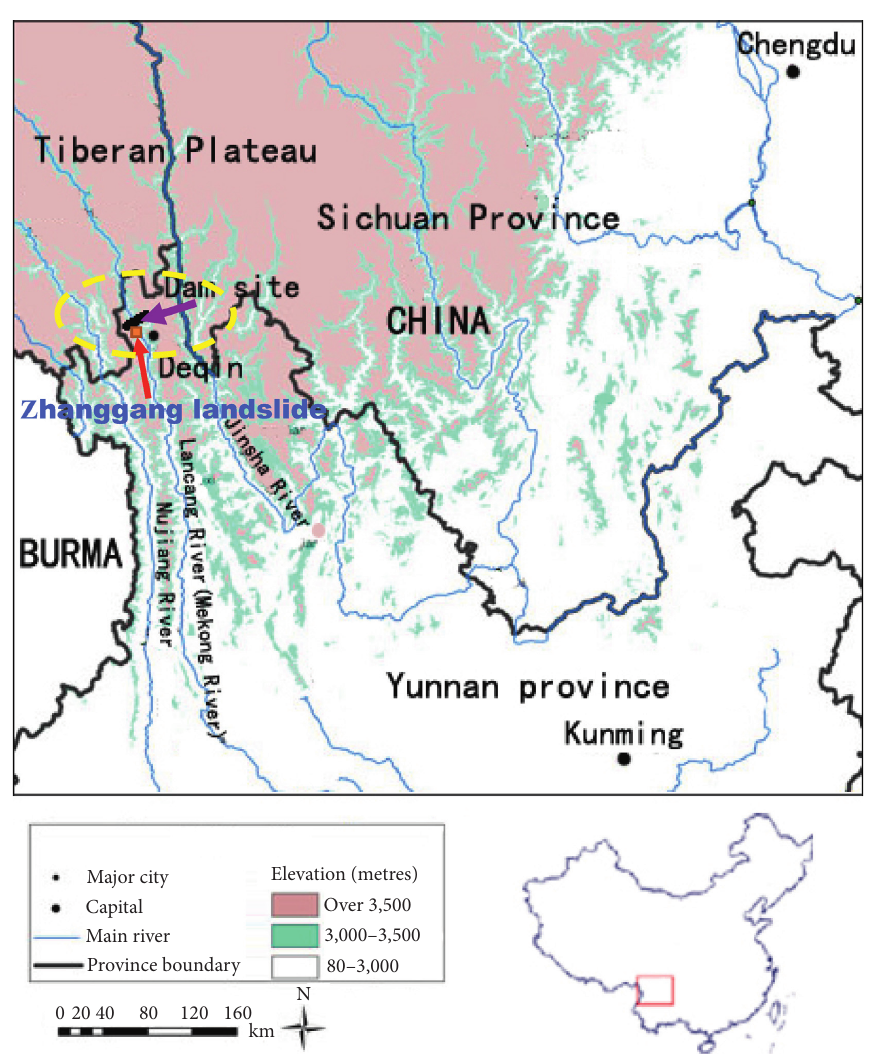
Figure 1: Location of the Zhenggang landslide near the Gushui Hydropower